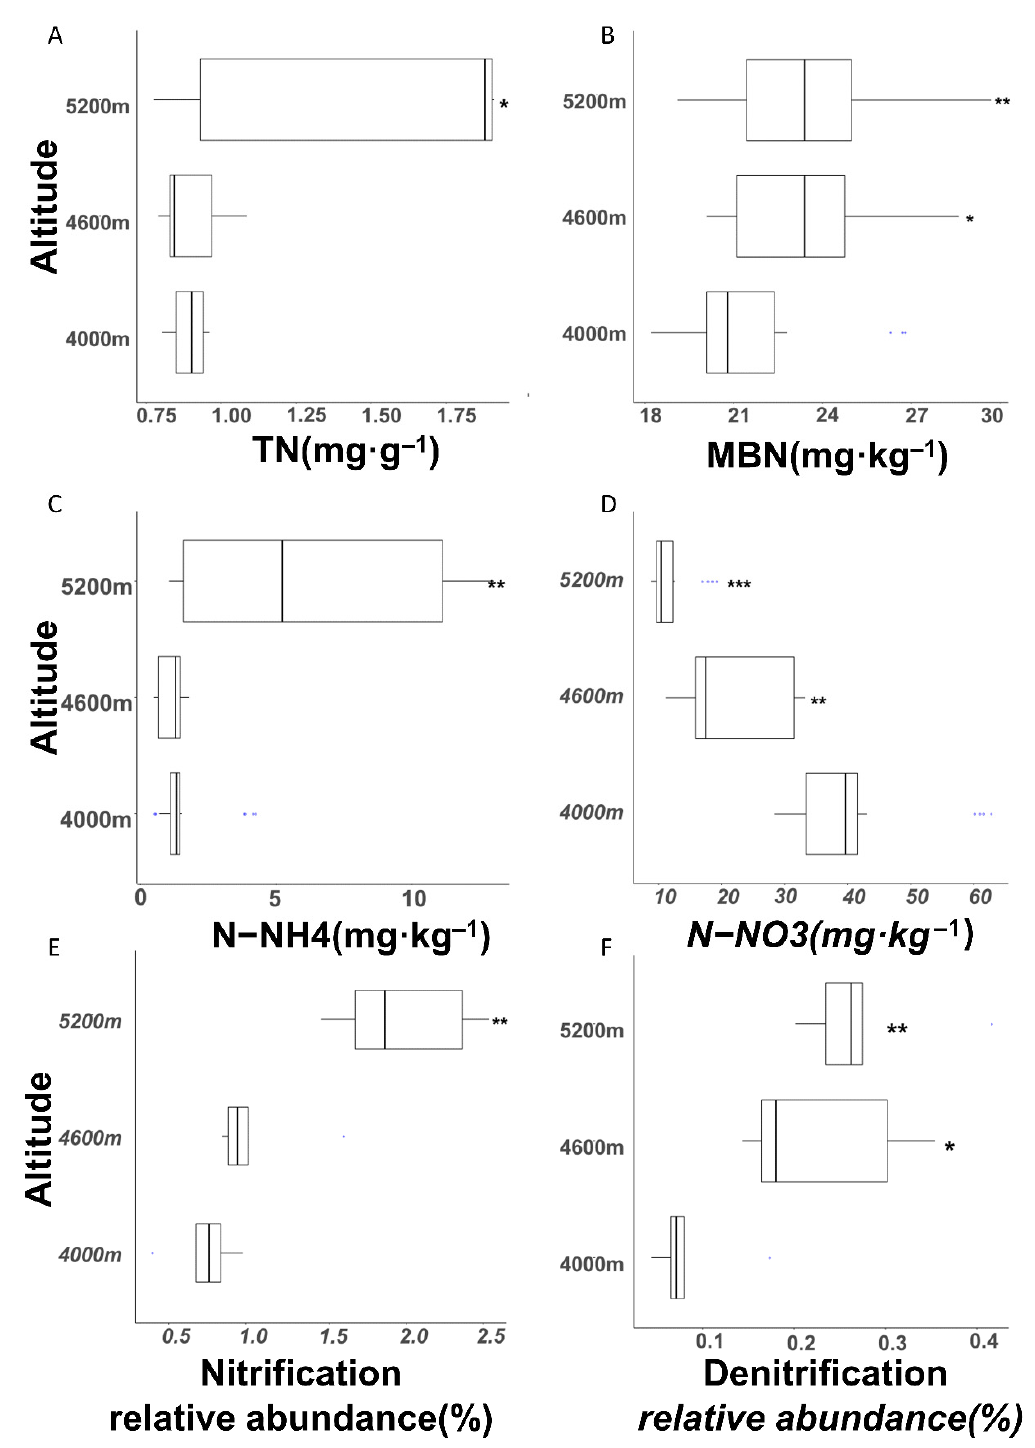
Figure 14. N cycle related indicators: ( A ) total soil nitrogen content, ( B ) soil microbial nitrogen content, ( C ) soil ammonia nitrogen N-NH 4 , ( D ) soil nitrate N-NO 3 , ( E ) nitrification bacteria relative content, ( F ) the relative content of denitrification bacteria at 4000 m (L), 4600 m (M), and 5200 m (H). * Means p < 0.05 for significance test; ** means p < 0.01 for significance test; *** means p < 0.001 for significance test.